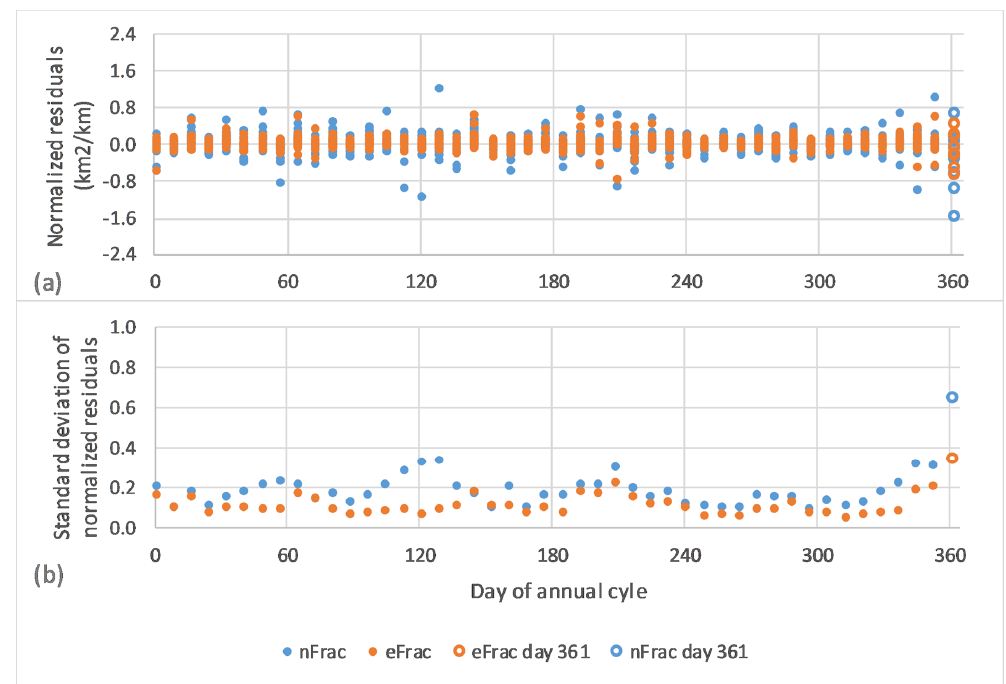
Figure 6. Comparison of residuals from lake surface area time-series nFrac and eFrac, as a function of the seasonal cycle (Julian Day). ( a ) Normalized residuals (km 2 /km) for all years, by day; ( b ) standard deviation of normalized residuals (km 2 /km) by day. Excluded data from Aqua MODIS Day 361 are shown as open circles.